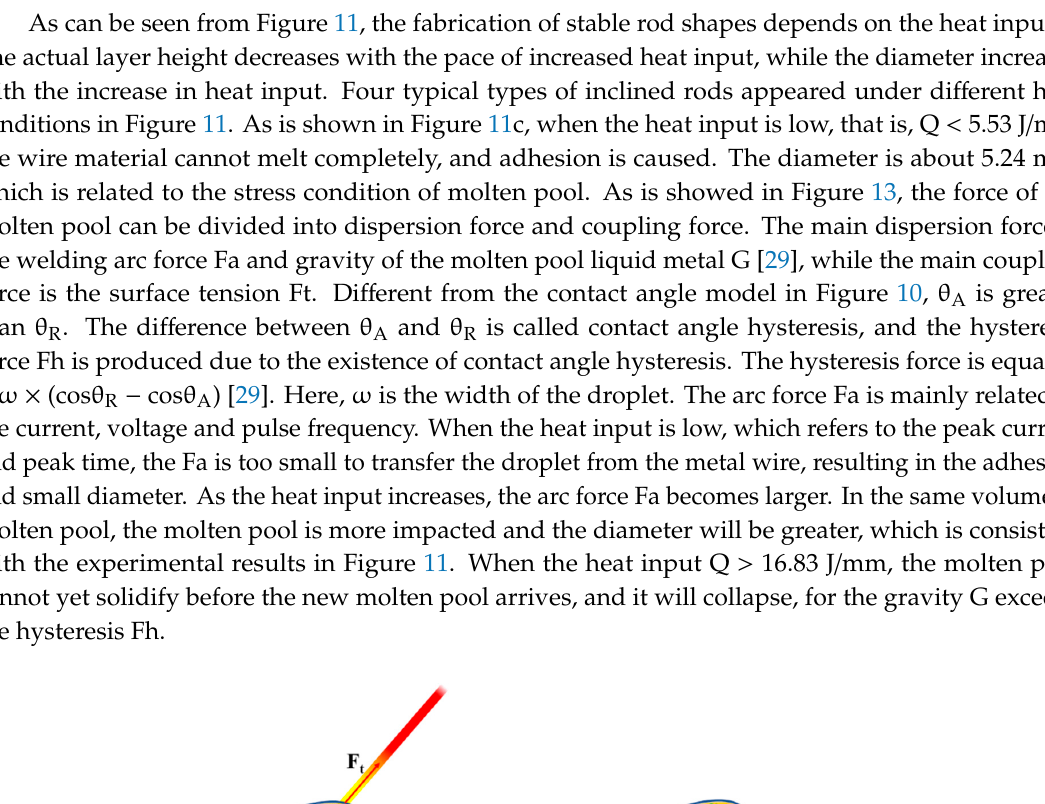
Figure 12. Schematic of manufacturing process with too-high layer height. ( a ) wire feeding; ( b ) Lap failure; ( c ) Peak current knocks down the wire.